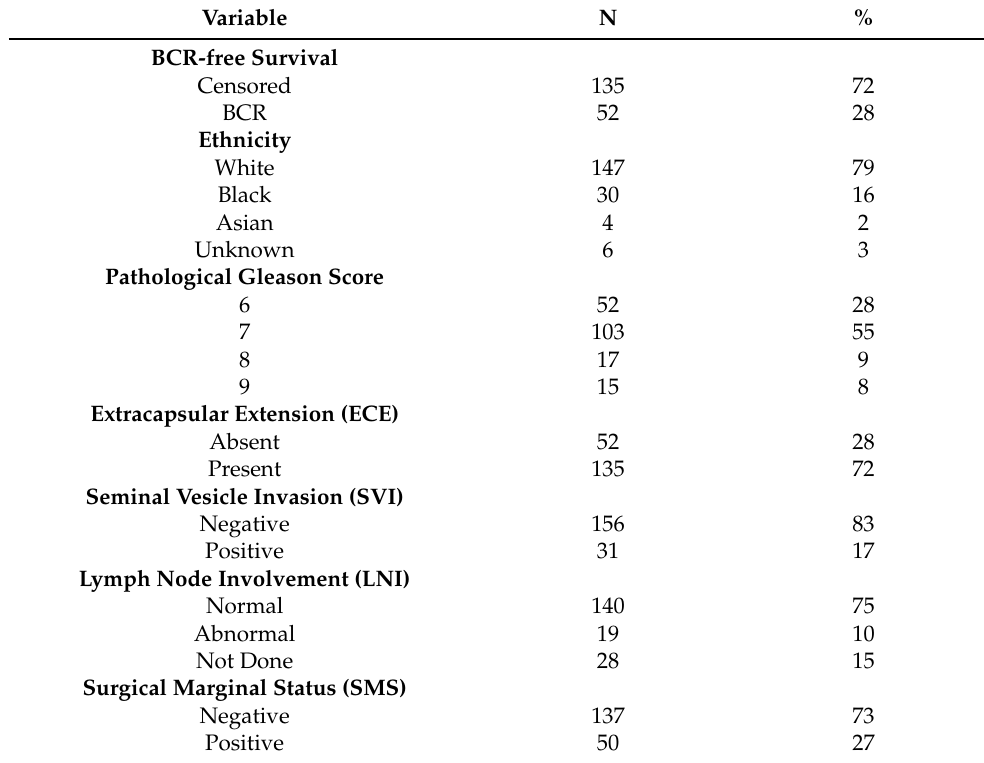
Table 1. Descriptive statistics of the categorical clinical